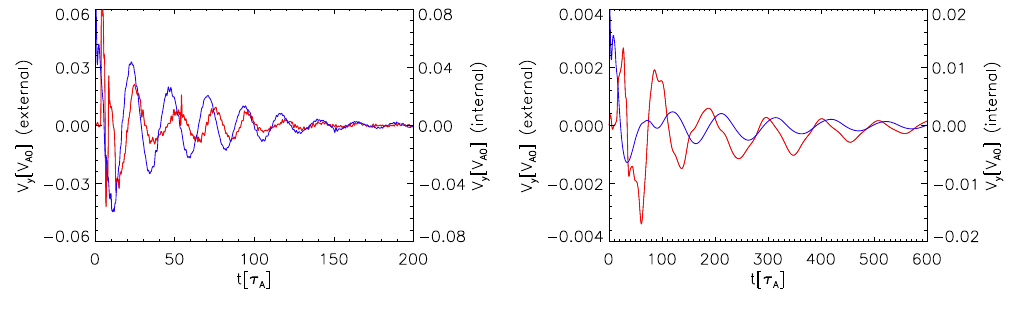
Fig. 4. Time signatures of transversal component of velocity at the cylindrical (left panel) and dipole (right panel) loop’s apex. Blue lines correspond to the excitation by the pulse inside the loop while red lines show the evolution after external excitation. of nonlinearity and dissipation. However, as the amplitude of the oscillation drops we are not able to study this effect in detail.